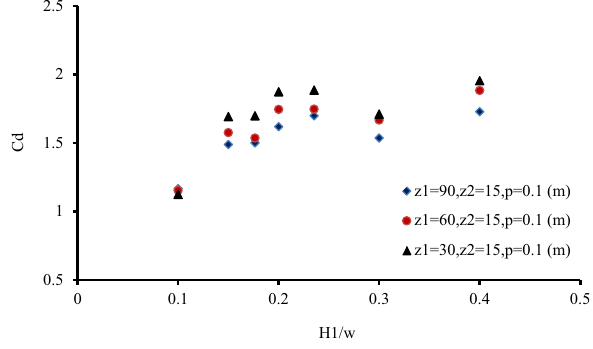
Fig. 6 Discharge coefficients for z heights